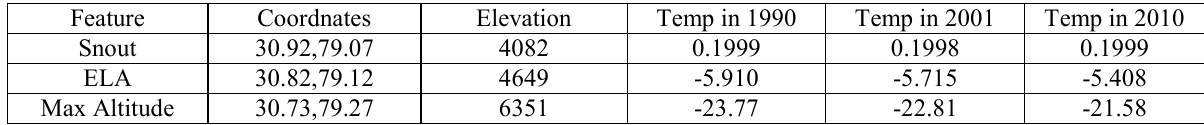
Table2. Feature wise Surface Temperature of Gangotri Glacier